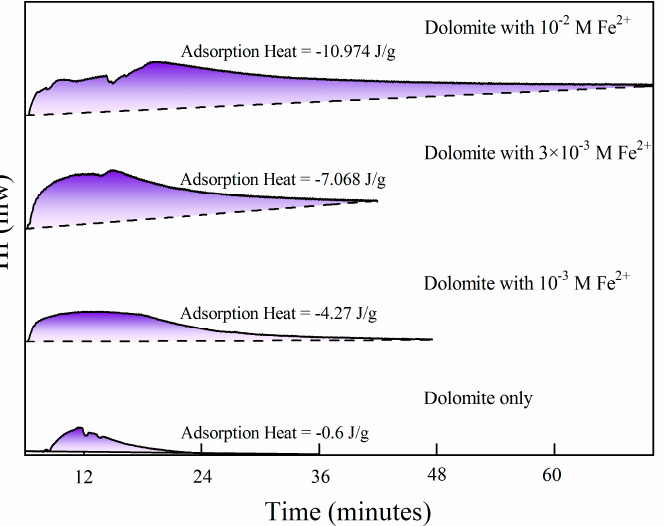
Figure 3. Adsorption heat of dolomite with SBX as the function of initial Fe 2+ concentration (pH = 8.5, c(SBX) = 10 − 3 M SBX).